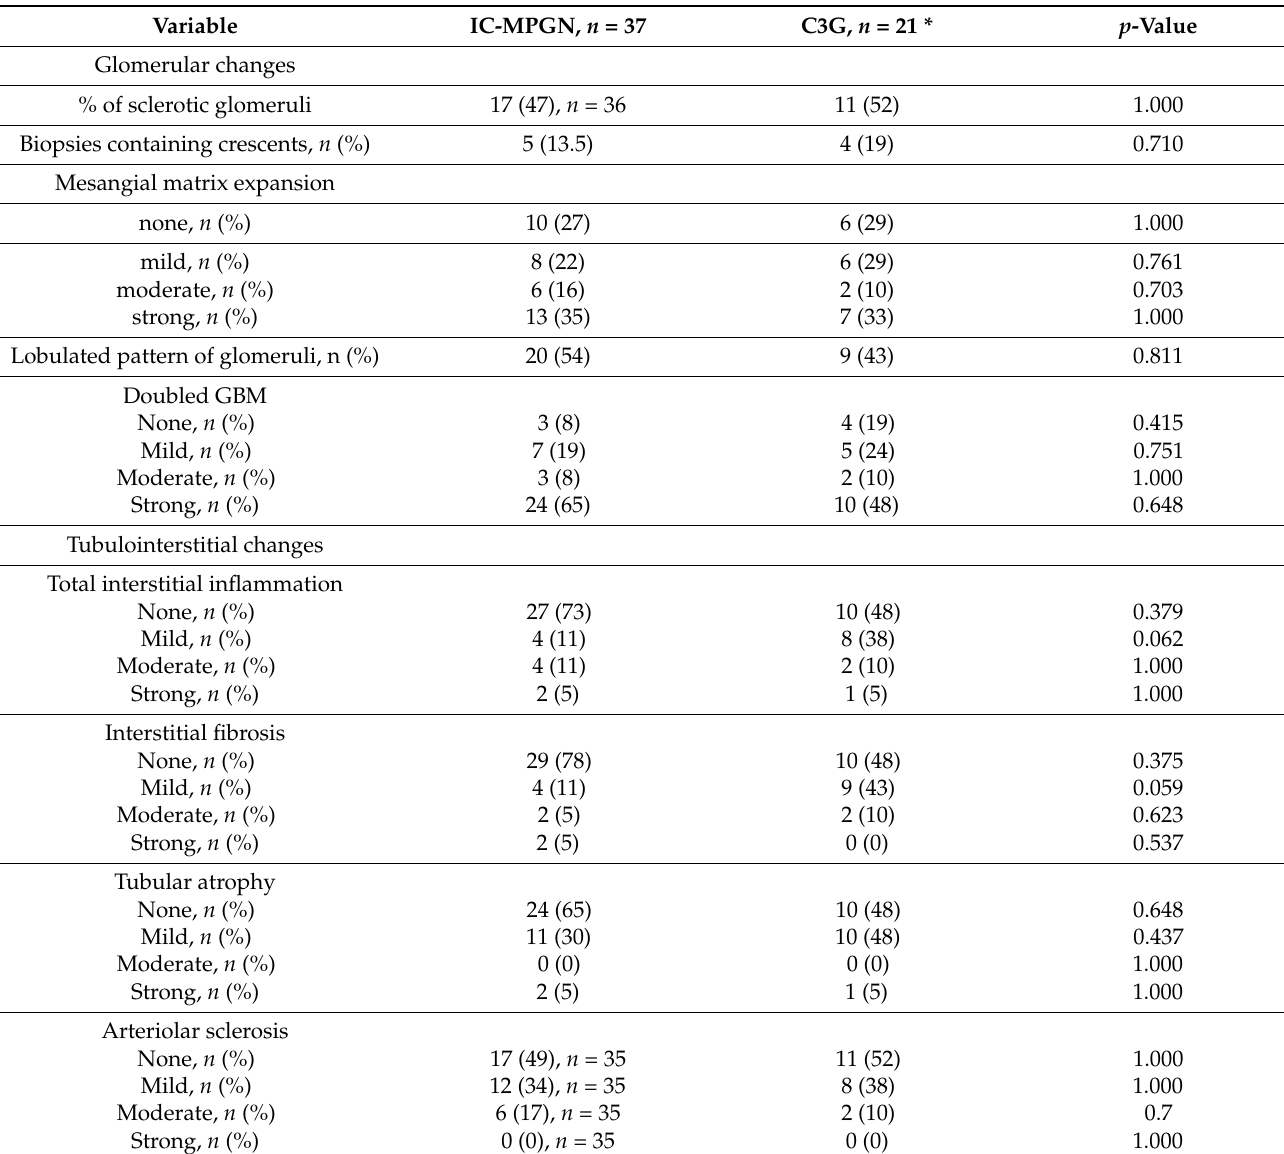
Table 3. Histological parameters of index biopsies. Values are expressed as means (SD) or numbers (percentage) of patients. The number of patients signifies the maximum number of patients with the information